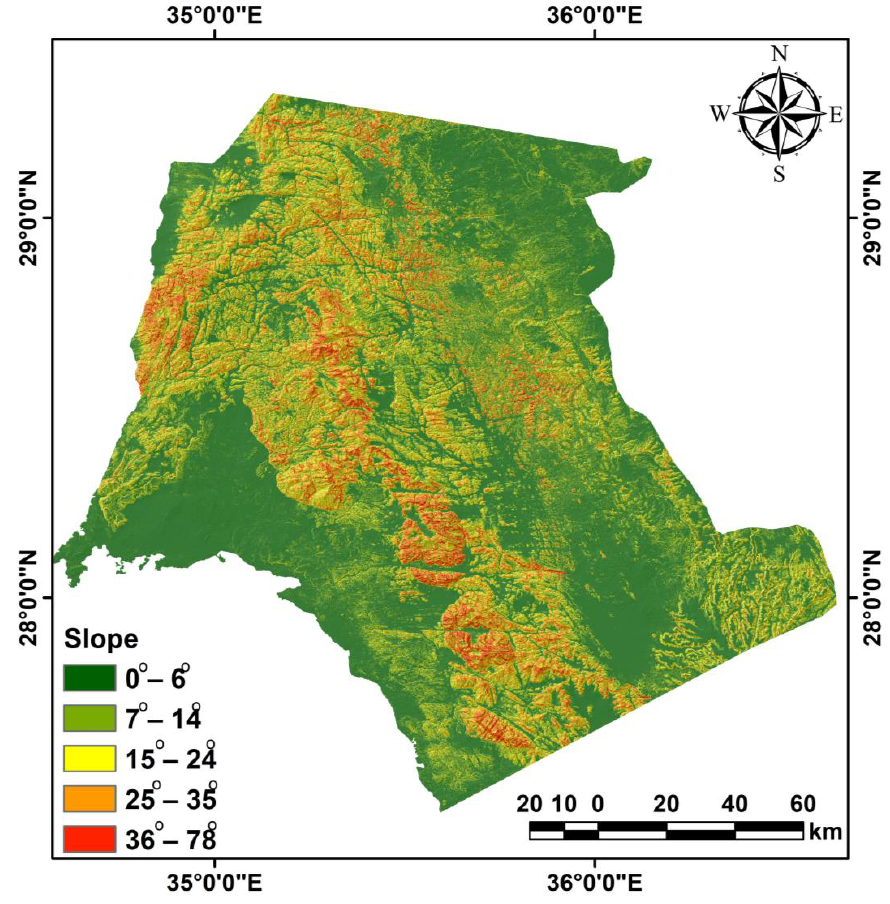
Figure 6. Map showing that the slopes of the study area are steep in the mountainous region and flat to the east and west of the Neom area.